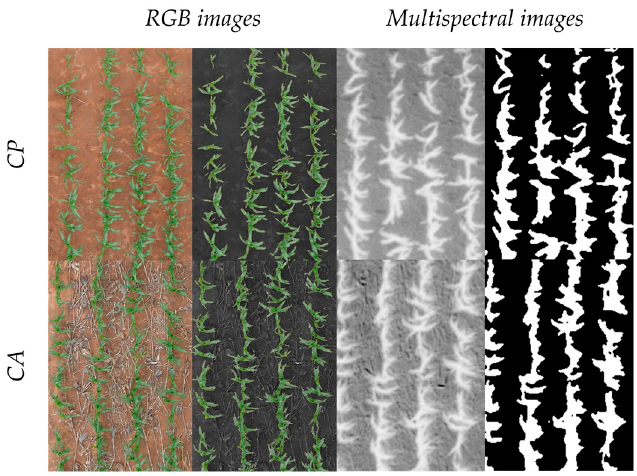
Figure 5. Examples of the differences in the vegetation area identification with the RGB and multispectral images with at the conservation (ca) and conventional (CP) plots.